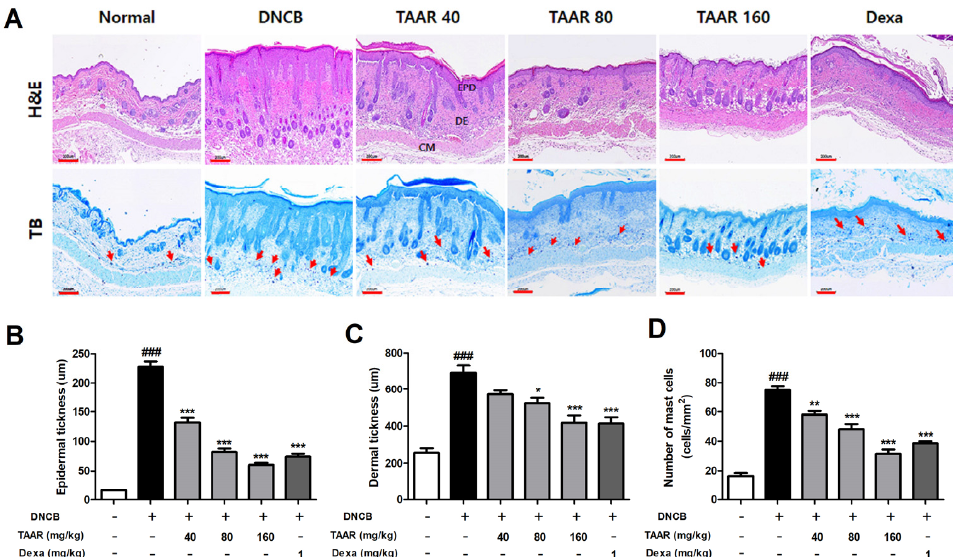
Figure 7. Effects of TAAR extract on histological features in the dorsal tissue of DNCB-induced mice. ( A ) Representative images of H&E and TB staining of the mice dorsal skin tissue (scale bar: 200 μ m). Mast cells are indicated by red arrows. ( B ) Epidermal thickness, ( C ) dermal thickness, and ( D ) number of infiltrated mast cells. All values are presented as the mean ± SEM of three experiments. Data were analyzed by Tukey’s post hoc test. ### p < 0.001 vs. normal control group; * p < 0.05, ** p < 0.01, and *** p < 0.001 vs. DNCB-treated only group.